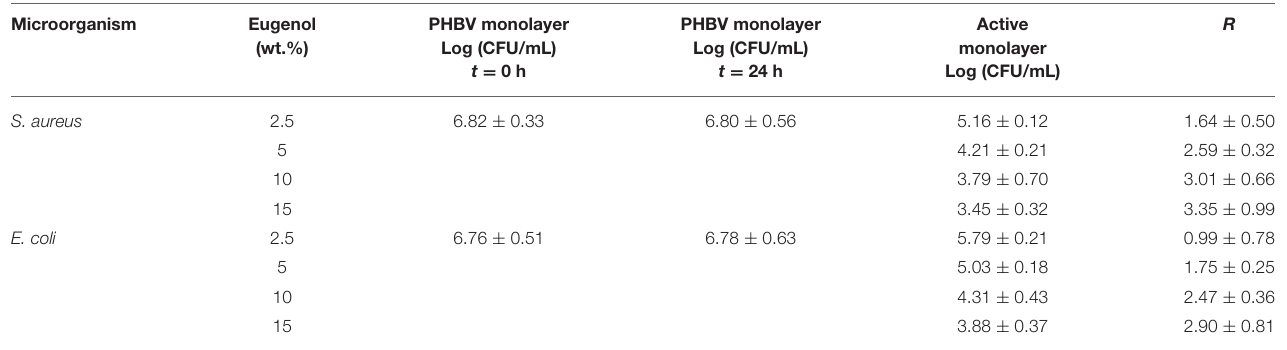
TABLE 2 | Antibacterial reduction (R) for Staphylococcus aureus ( S. aureus ) and Escherichia coli ( E. coli ) of the electrospun monolayers of poly(3-hydroxybutyrate- co -3-hydroxyvalerate) (PHBV) containing different amounts of eugenol in the open system for 24h. Microorganism Eugenol